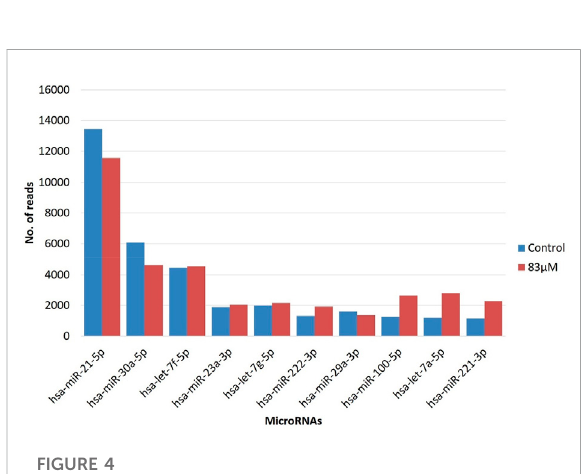
FIGURE 4 Read count of top ten highly expressed microRNAs in MDA- MB-231 cells in the untreated control vs. 24 h of 83 μ M EGCG treatment. Color key-blue: untreated control, red: 83 μ M EGCG